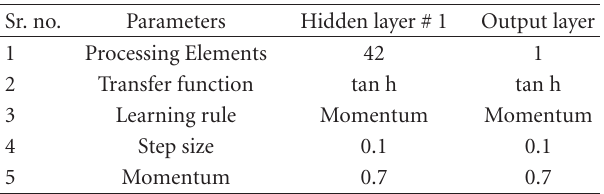
Table 1: Parameters of FTLR NN (Lab. data). Number of Exem- plars: Training = 268, Testing = 115, Max epoh = 1000, Focused, Gamma, Norm → L-infinity.